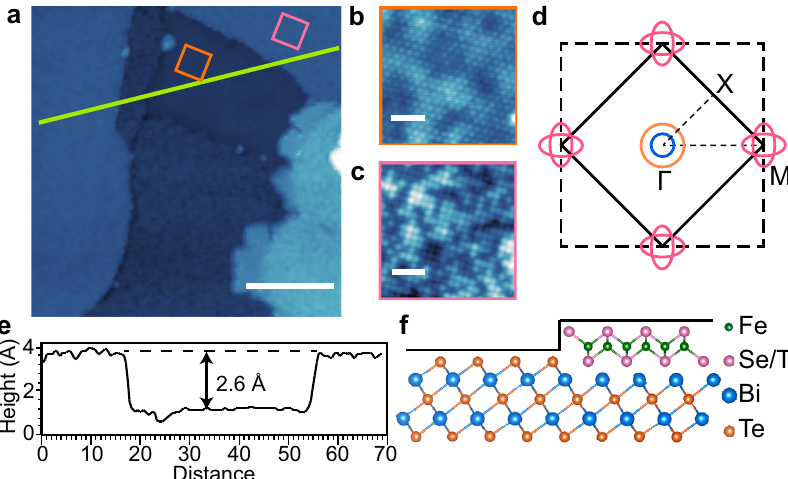
Fig. 1 Overview of Fe (Se,Te) lattice. a Topographic image of Fe (Se,Te) thin fi lm grown on Bi 2 Te 3 single crystal in a 100 nm × 100 nm area (bias voltage V b = 300 mV, tunneling current I t = 40 pA). Scale bar is 20 nm. b , c Atomic resolution topographies of Bi 2 Te 3 surface (Scale bar is 2 nm) and half-embedded Fe (Se,Te) island (Scale bar is 2 nm) respectively, taken within the orange and pink frames (8 nm × 8 nm) shown in a . d Fermi surfaces of Fe (Se,Te) in the crystallographic BZ. The high-symmetry point labels and solid lines refer to the 2-Fe BZ, while the “ unfolded ” 1-Fe BZ is denoted by the dashed line. e , Height pro fi le taken along the green line in a , which shows the height of half-embedded Fe (Se,Te) island is about 2.6 Å. f Schematic lattice structure of the heterostructure between Bi 2 Te 3 single crystal and half-embedded Fe (Se,Te) thin fi